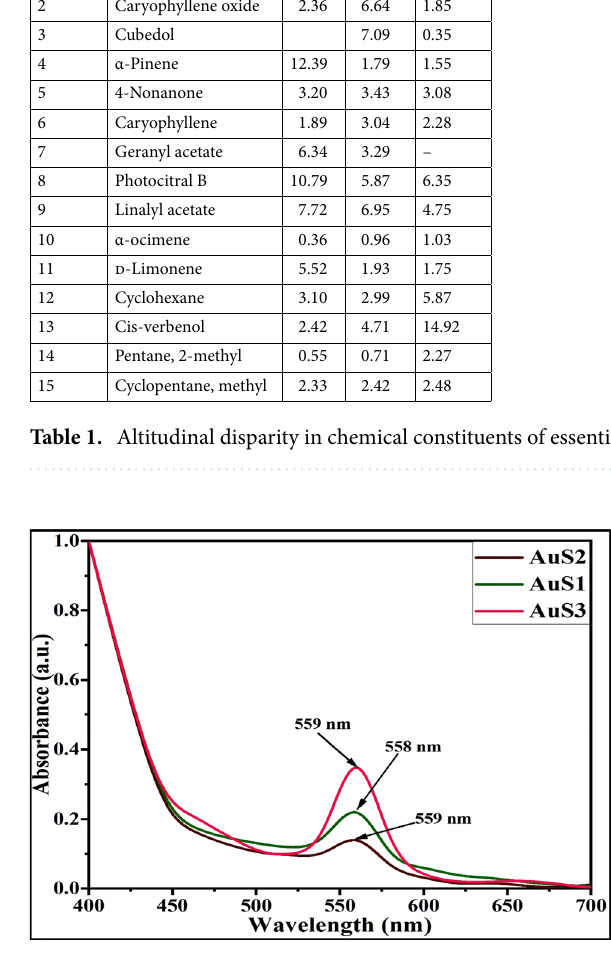
Figure 4. UV–Vis spectra of AuNPs using essential oil extracts of C . flexuosus from different altitudes, i.e., Palampur AuS1 ( a ), Haryana AuS2 ( b ), and Dehradun AuS3 ( c